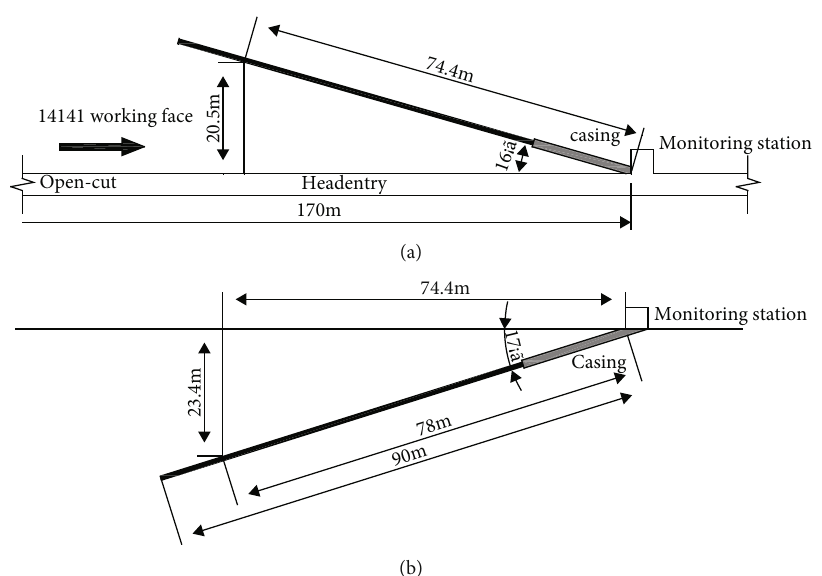
Figure 17: The borehole parameters for the direct current (DC) method. (a) The designed borehole plan. (b) The designed borehole pro fi